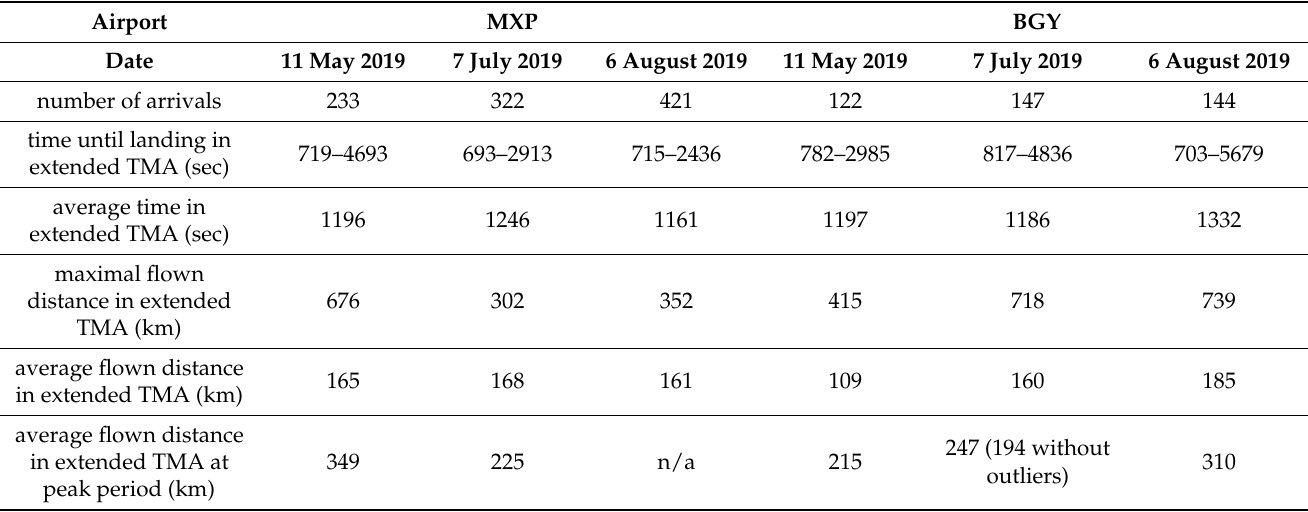
Table 1. Data summary of available historical